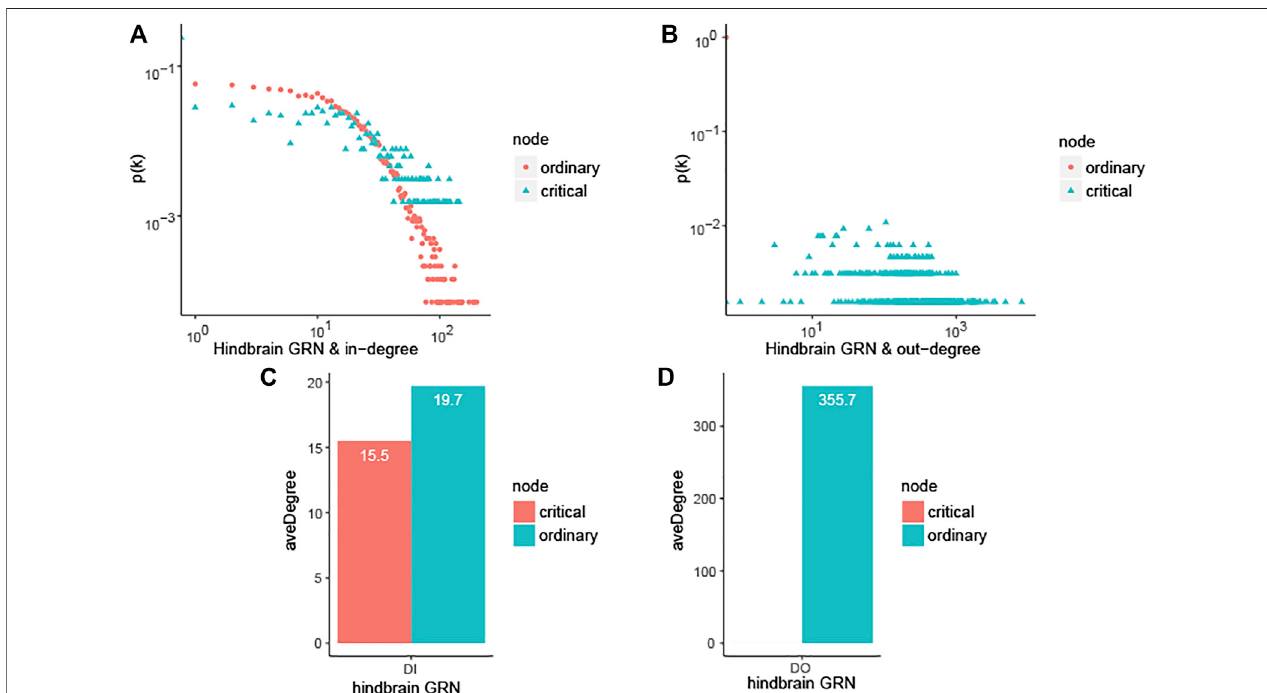
FIGURE 1 | Characterizing the controllability of human brain-speci fi c gene regulatory network and topological analysis. In the fi gure, hindbrain GRN is hindbrain gene regulatory network, forebrain GRN is forebrain gene regulatory network, neuron associated cells cancer related GRN isneural gene regulatory network associated cells cancer ( Table 2 ).The values in Table 2 are the average of those topological characteristics that consist of out-degree DO , in-degree DI , degree D , betweenness B , closeness CA , in-closeness CI , out-closeness CO , betweenness B and clustering coef fi cient CC . (A) In-degree distribution of hindbrain GRN. (B) Out-degree distribution of hindbrain GRN. (C) Average in-degree for ordinary and critical nodes in hindbrain GRN. (D) Average out-degree for ordinary and critical nodes in hindbrain GRN.